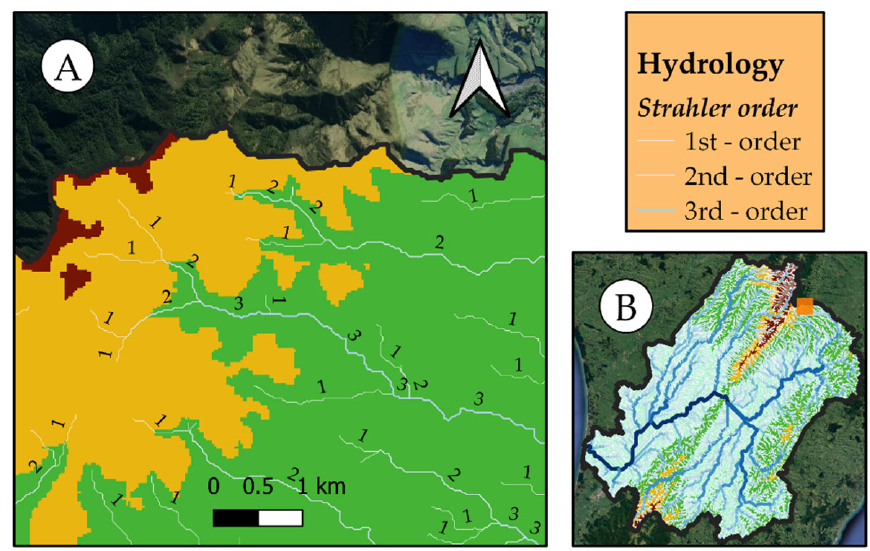
Figure 5. ( A ) Demonstration of Strahler order methodology (numbers are showing its stream order). ( B ) Overview map. The channel network calculated from SRTM model.